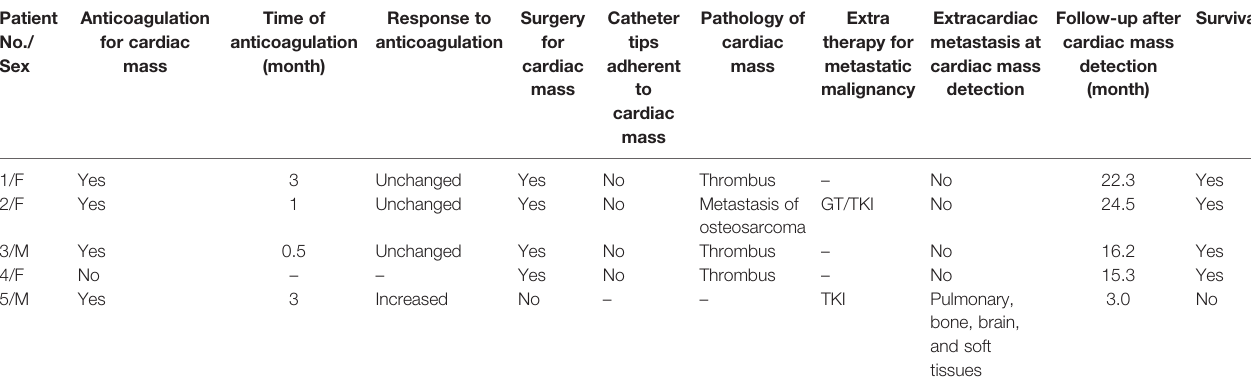
TABLE 3 | Treatments and outcomes of cardiac masses in pediatric patients with bone sarcoma. Patient